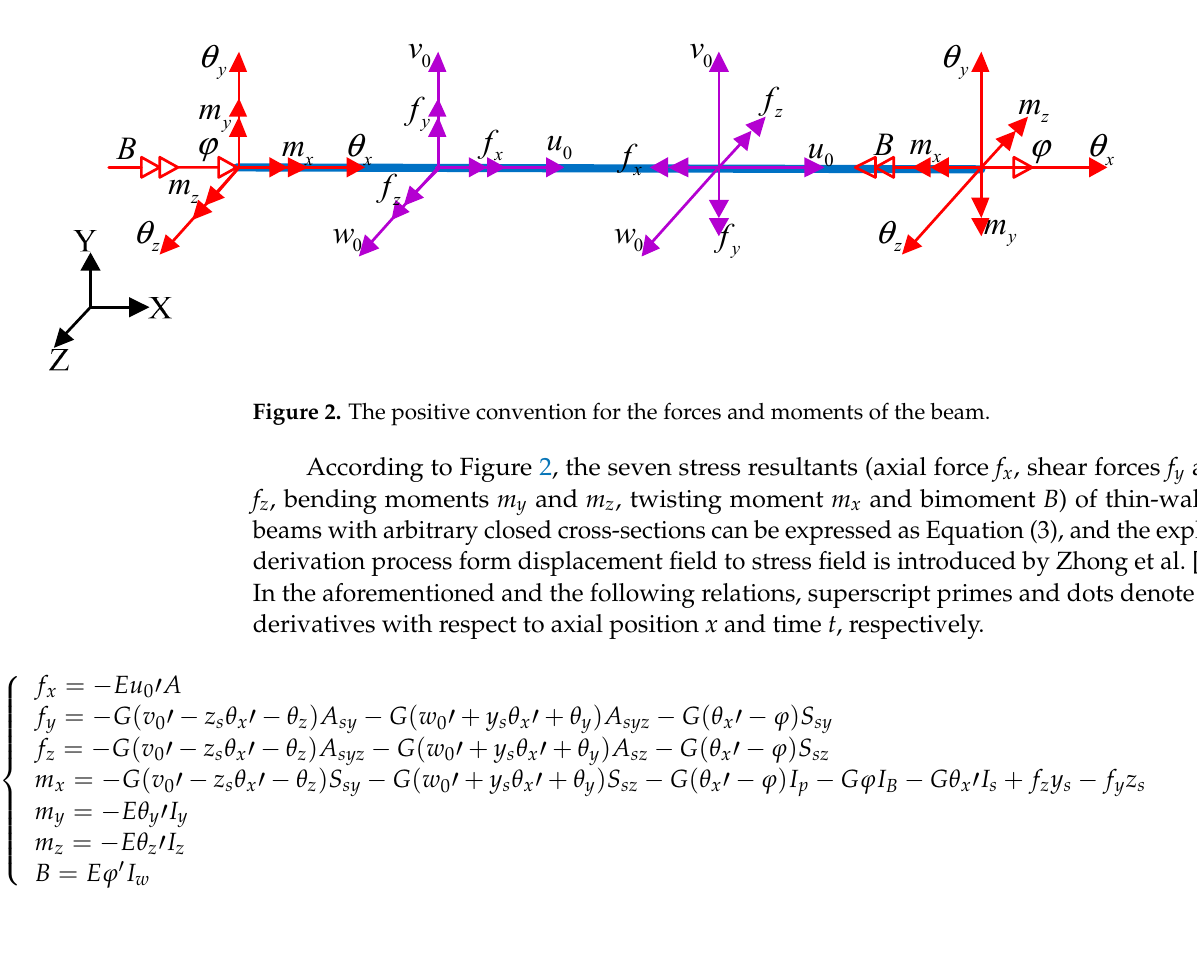
Figure 1. Element geometry of the beam and the details of the cross-section. The positive convention of forces and moments is indicated in Figure 2, in which the bimoment is independent of the coordinate system [30].